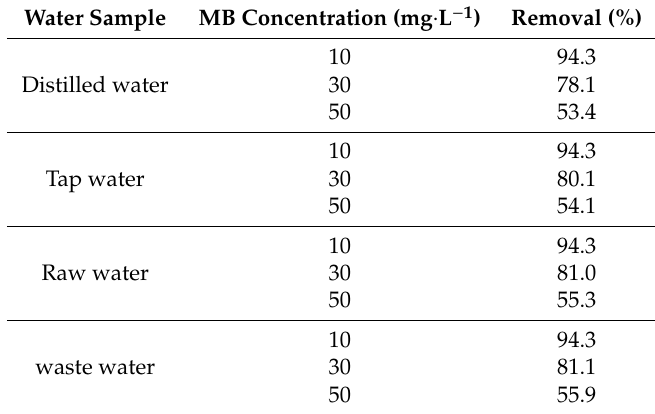
Table 7. Adsorptive removal of MB dye from real water samples’ SLS-C